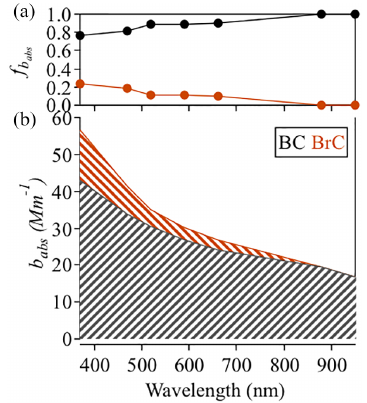
Figure 3. (a) Fractions of BC and BrC contributions to aerosol particle light absorption at different wavelengths. (b) Contributions of BC and BrC to the total light absorption coefficient at different